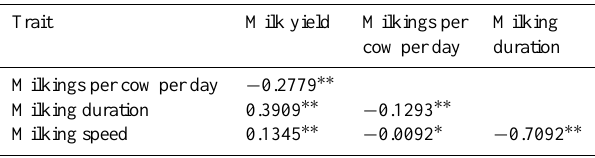
Table 3. Pearson correlation coefficients together with their signif- icance between the cow milking parameters